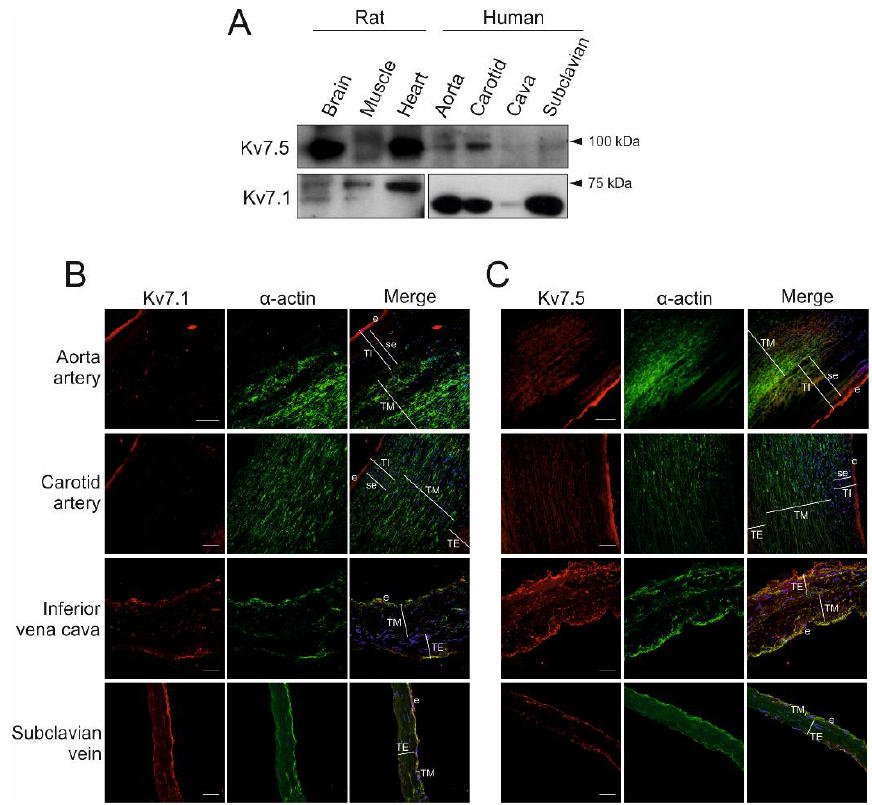
Figure 1. Voltage-dependent potassium (Kv)7.1 and Kv7.5 are differentially expressed in human blood vessels. ( A ) Membrane protein extracts were obtained from several human blood vessels (aorta and carotid arteries and inferior cava and subclavian veins) and rat tissue samples (brain, skeletal muscle and heart). ( B and C ) Fresh human samples were obtained and processed as described in the Materials and Methods. Sections were stained with anti-Kv7.1 ( B ) or anti-Kv7.5 ( C ) antibodies. Then, α-actin was used to identify muscle structures. Red, Kv7.1 ( B ) and Kv7.5 ( C ) channels; green, α-actin; merge, superimposed channel, α-actin and nuclear DAPI staining (in blue). TI: tunica intima; TM: tunica media; TE: tunica externa; e: endothelial layer; se: subendothelial layer. Scale bars: 50 μm in cava and subclavian veins; 100 μm in carotid artery; 250 μm in aorta artery.